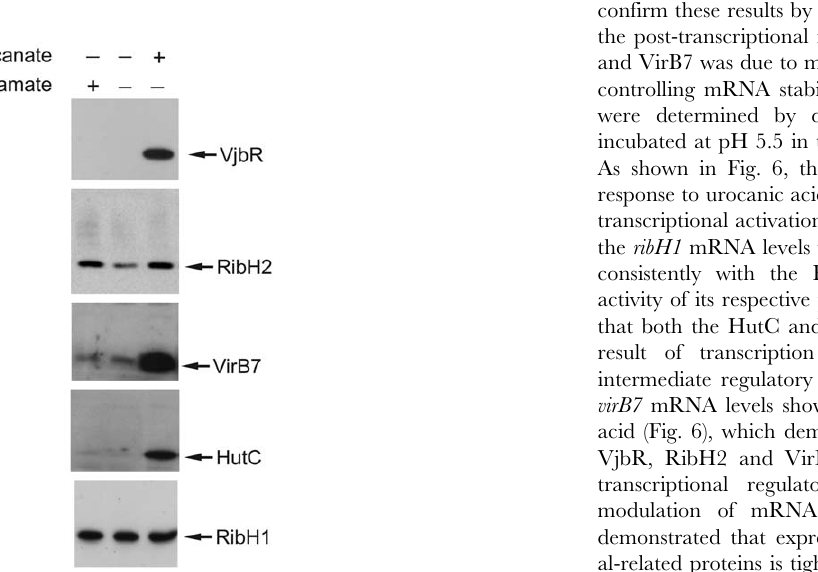
Figure 5. Comparison between glutamic acid and urocanic acid as inducer signals. Strain B. abortus 2308 grown in TSB and shifted to MM1 at pH 5.5, in the presence of 5 mM glutamic acid, 5 mM urocanic acid, or without the addition of any carbon source, as indicated. Subsequently, OD 600 was determined, and samples were analyzed by western blot using anti-VjbR, anti-RibH2, anti-VirB7, anti-HutC or anti- RibH1 polyclonal antibodies.